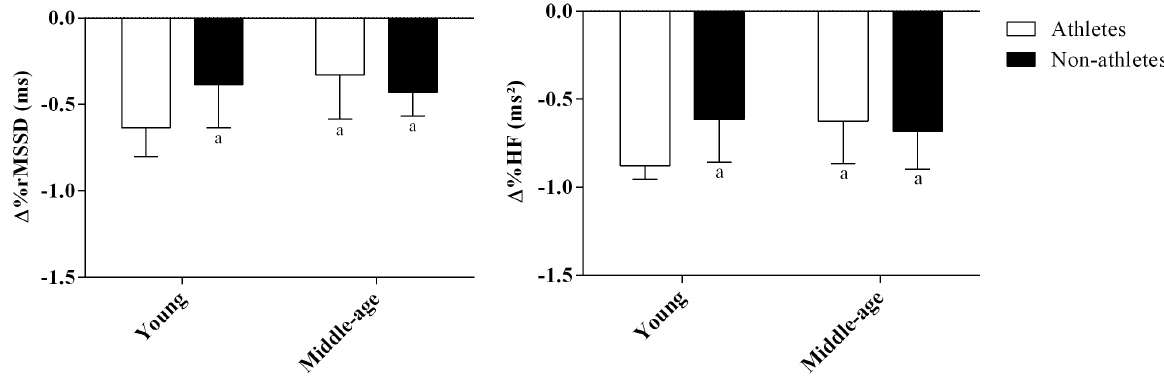
Figure 1. Comparison of %ΔrMSSD and %ΔHF among in young and middle age individuals athletes or not. a= differences from young athletes. %Δ= ORT-SUP/SUP. Mean ±SD; Two-way ANOVA with Tukey’s post hoc.